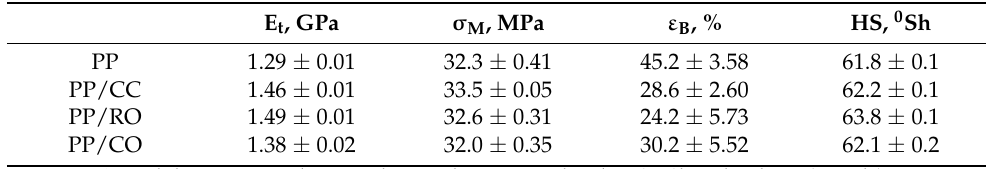
Table 3. Mechanical properties of unaged iPP and the obtained